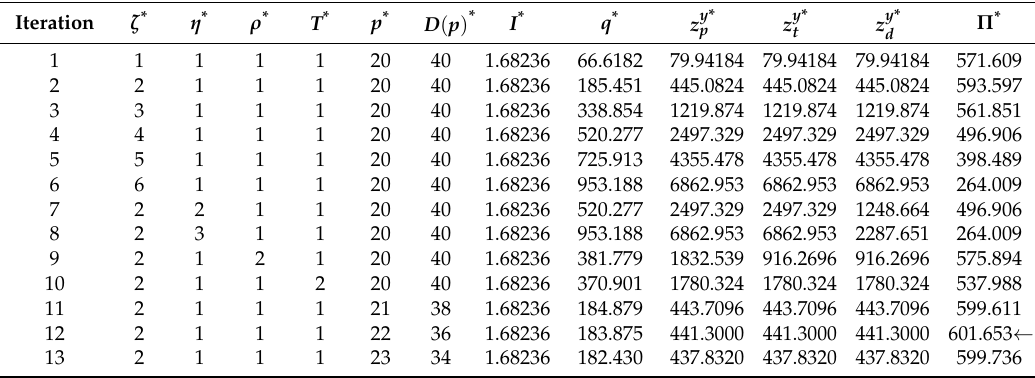
Table 3. Details of the procedures for the